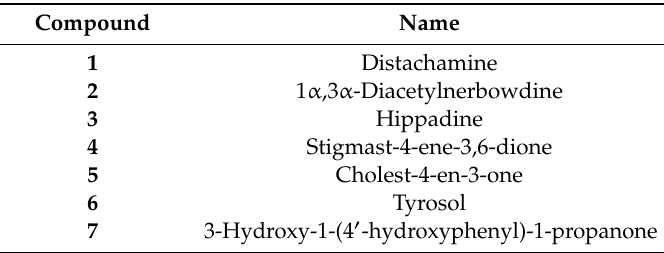
Table 2. Table showing list of compounds isolated from Boophone haemanthoides extract